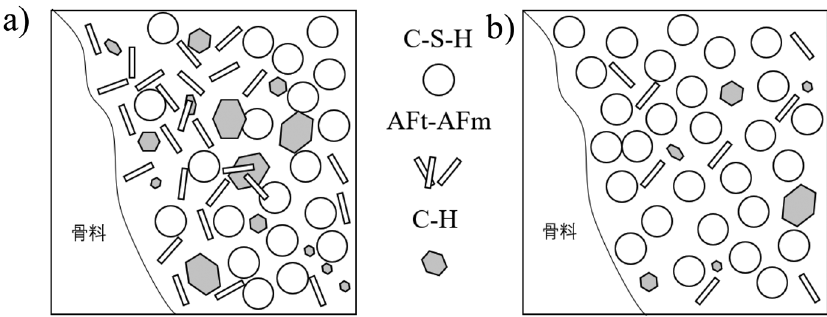
Figure 3: Concrete interfacial transition zone model: ( a ) common mixing interface transition zone and ( b ) vibratory mixing interface transition zone.